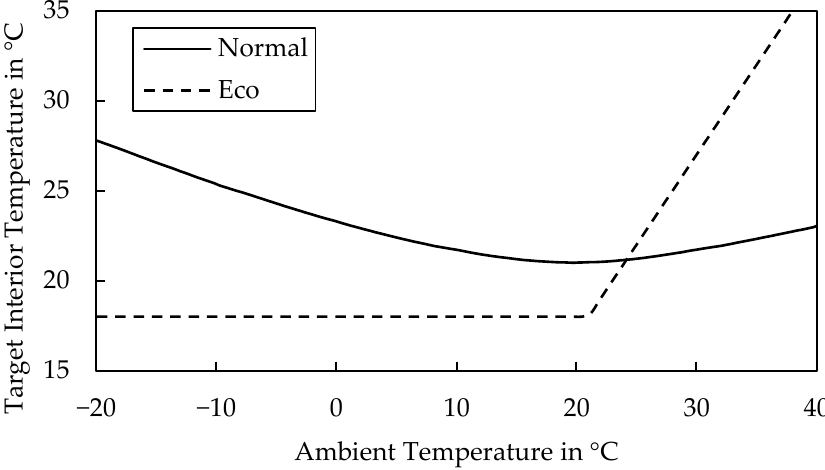
Figure 5. Target interior temperature curves used by the controller, based on [21–23].